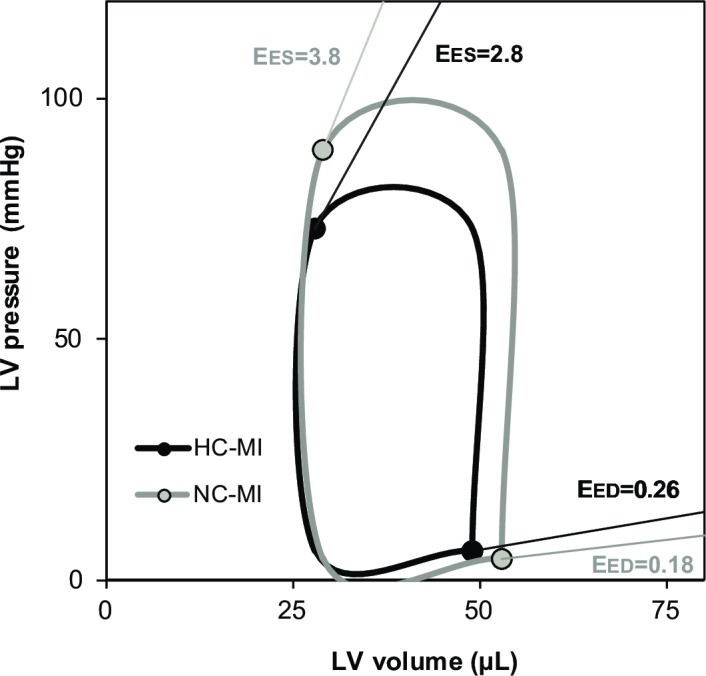
Pressure-volume loops.PV loops 8 weeks after MI-R of the NC-MI and HC-MI groups. The oblique lines represent the end-systolic (EES) and end-diastolic (EED) pressure-volume relations.